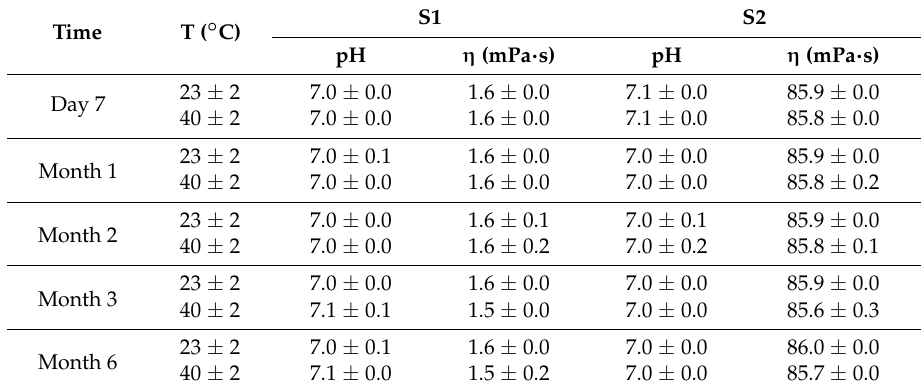
Table 1. Stability of S1 and S2 during 6 months, at 23 ± 2 °C and at 40 ± 2 °C: pH and viscosity values. Time T ( ◦ C) pH η (mPa ·